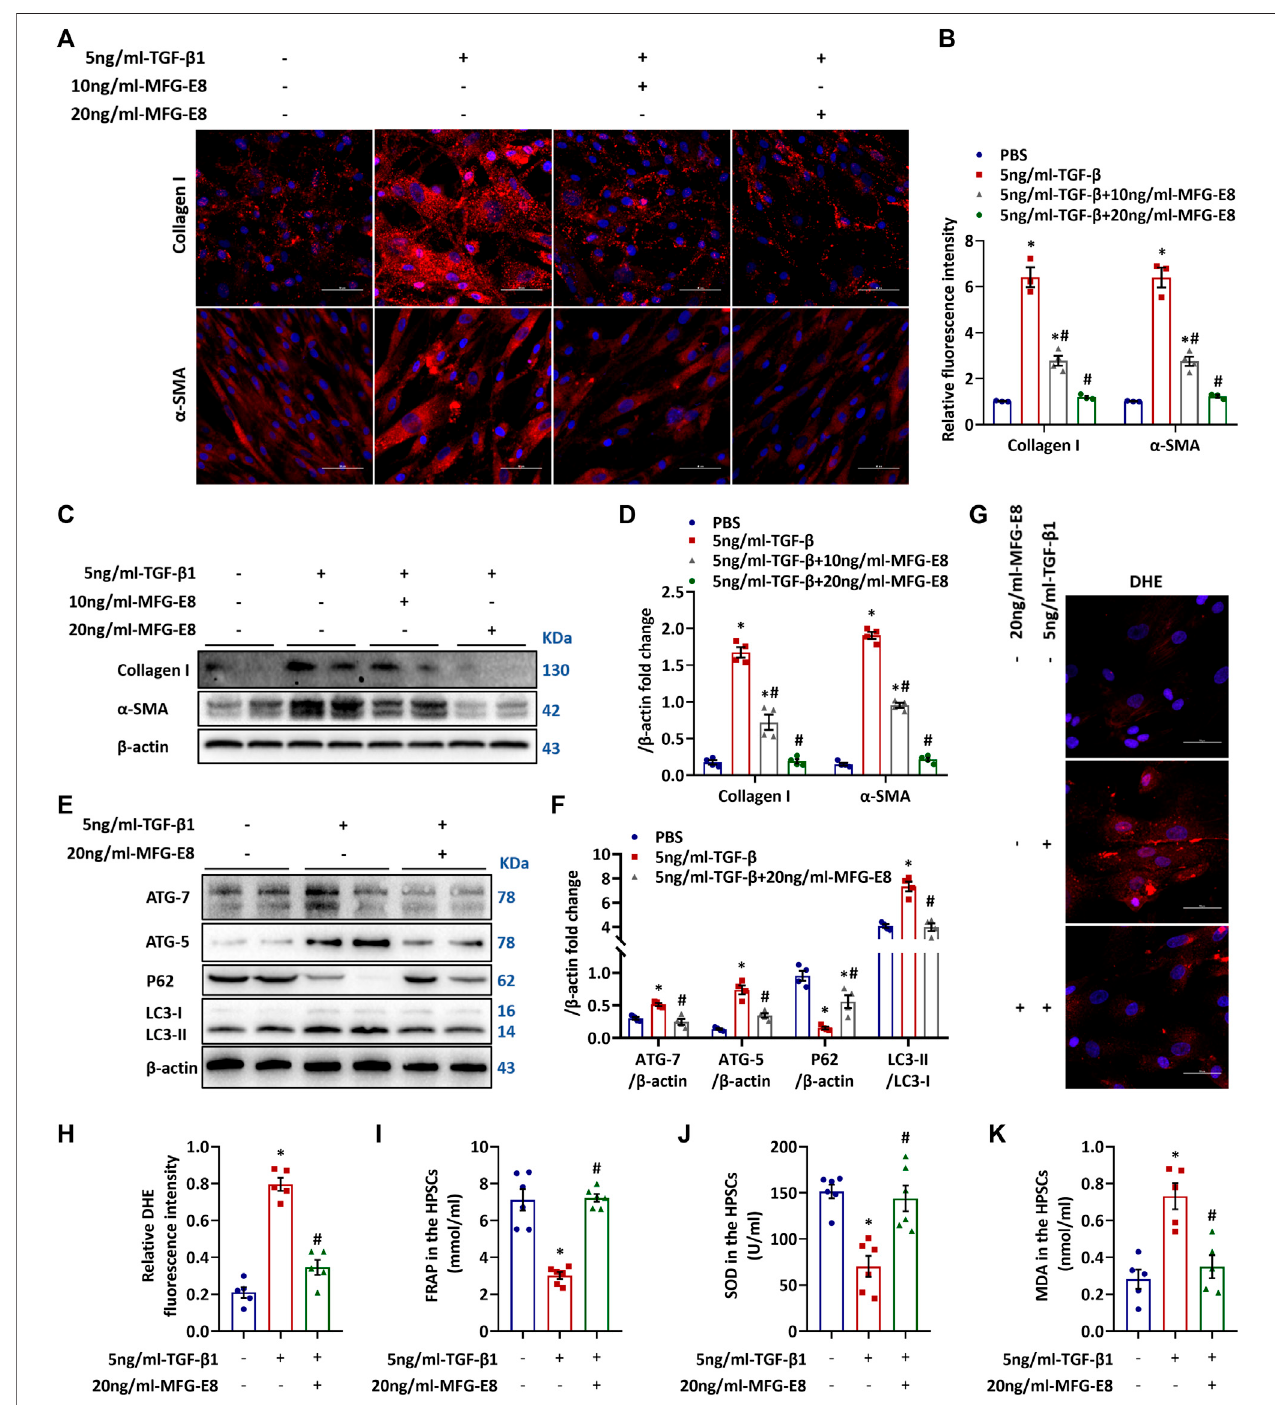
FIGURE 4 | ExogenousMFG-E8BlocksTGF- β 1 – inducedactivationofHPSCs. Humanpancreaticstellatecells(1 × 10 6 /well)weretreatedwith5 ng/mlTGF- β 1withor without10 ng/mlor20 ng/mlMFG-E8for24 h,thesamevolumeofPBSwasaddedtoanothergroupofHPSCsasacontrolgroup. (A,B) Representativeimagesandquantitative analysis of immuno fl uorescence staining of α -SMA and collagen I in the HPSCs (one-way ANOVA with the Tukey-Kramer test); (C,D) Western blot analysis of the expression of α -SMAandcollagenIintheHPSCs(one-wayANOVAwiththeTukey-Kramertest); (E,F) WesternblotanalysisoftheexpressionofATG7,ATG5,P62andLC3BintheHPSCs (one-wayANOVAwiththeTukey-Kramertest); (G,H) Representativeimagesandquantitativeanalysisofimmuno fl uorescencestainingofDHEintheHPSCs(one-wayANOVAwith theTukey-Kramer test); (I) FRAPlevel in theHPSCs (one-way ANOVA with theTukey-Kramer test); (J) SOD levelin theHPSCs(one-way ANOVA with theTukey-Kramer test); (K) MDAlevelintheHPSCs(one-wayANOVAwiththeTukey-Kramertest). n (cid:1) 3 – 6,mean ± SEM; p p < 0.05versusShamgroup;# p < 0.05versusVehiclegroup. α -SMA,alpha-smooth muscleactin;TGF- β 1,transforminggrowthfactor- β 1;HPSCs,humanpancreaticstellatecells,MDA,malondialdehyde;SOD,superoxidedismutase;MFG-E8,MilkFatGlobule-EGF Factor 8; FRAP, Ferric ion reducing antioxidant power; DHE, Dihydroethidium.